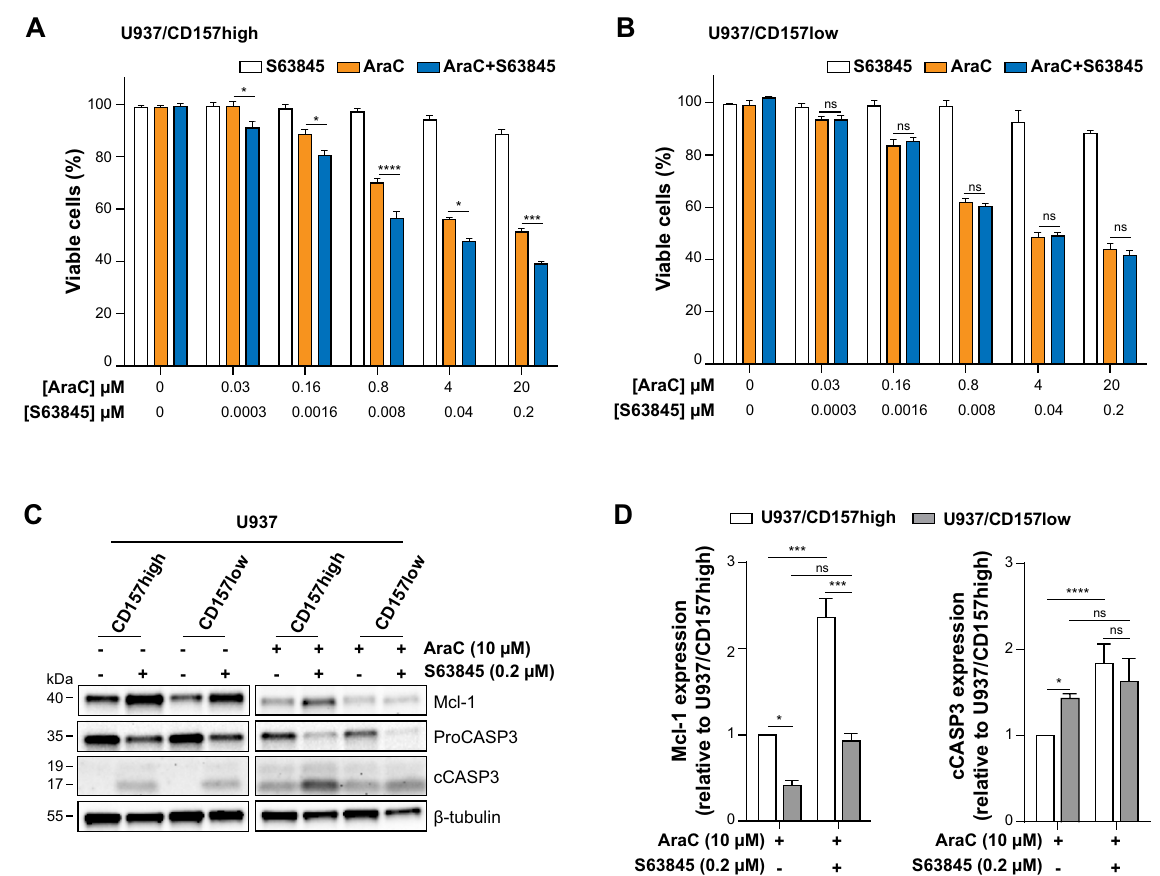
Figure 5. Mcl-1 inhibition improves therapeutic efficacy of AraC in CD157-high AML cells. ( A ) U937 / CD157- high or ( B ) U937/CD157-low cells were treated for 24 h with increasing concentrations of S63845 or AraC as single drugs or in combination, at constant ratio S63845:AraC = 1:100. Cell viability was measured by PrestoBlue assays and was expressed as fold change of viable cells compared to cells maintained in standard culture conditions. ( C ) Western blot analysis of U937/CD157-high or U937/CD157-low cells left untreated or treated for 24 h with S63845 or AraC as single agents or in combination. Uncropped blot images are provided in Supplementary Fig. S12. ( D ) The levels of Mcl-1 (left), and cleaved Caspase-3 (right) proteins determined by densitometry analysis was compared in CD157-high (white bars) or CD157-low (grey bars) U937 cells treated with AraC as single drug or in combination with S63845 for 24 h. Relative band intensities of the target proteins were measured by densitometric analysis. Results are means ± SEM of band densities of western blots from three separate experiments and are expressed as fold change over AraC-treated U937/CD157-high cells. * p < 0.05, ***p < 0.001, **** p < 0.0001, ns = not significant, two-way ANOVA with Sidak’s multiple comparison